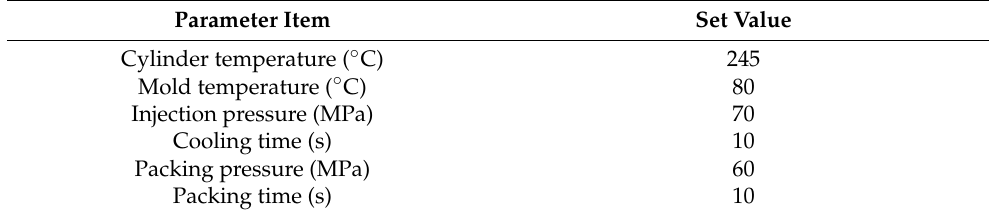
Table 1. Injection process parameter